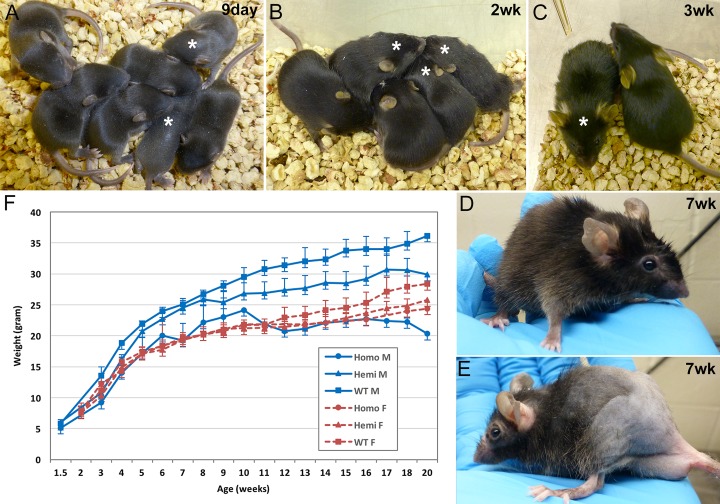
The FLExDUX4 lines of mice.(A-D) Hemizygous (*)FLExDUX4/+ mice are healthy, active, and fertile with a very mild alopecia that is readily distinguishable from wildtype littermates starting at two weeks of age. (E) Homozygous FLExDUX4/FLExDUX4 mice are also healthy, active, and fertile but show more prominent alopecia than hemizygous mice. F) These transgenic mice are initially similar in size and weight as their control non-transgenic siblings; however, the hemizygous and homozygous are smaller as adults. The graph shows average weights for n = 5+ animals for each genotype measured each week for 20 weeks.